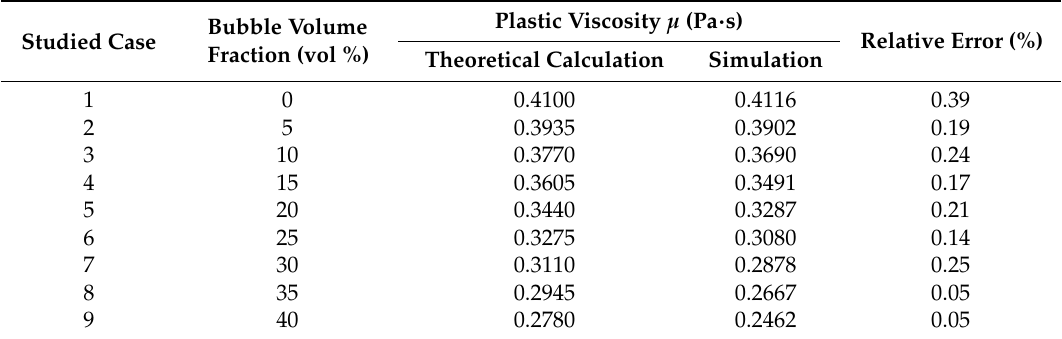
Table 3. The value of plastic viscosity by theoretical calculation and simulation.